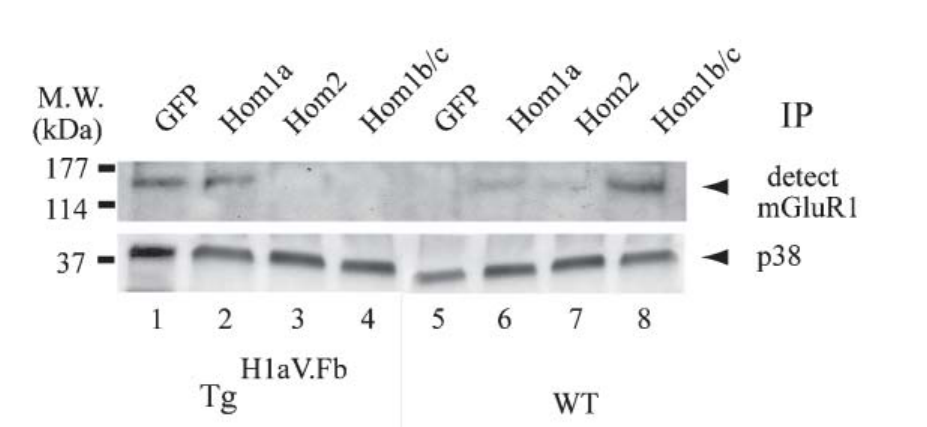
| | | Frontiers in Neuroscience November 2007 Volume 1 Issue